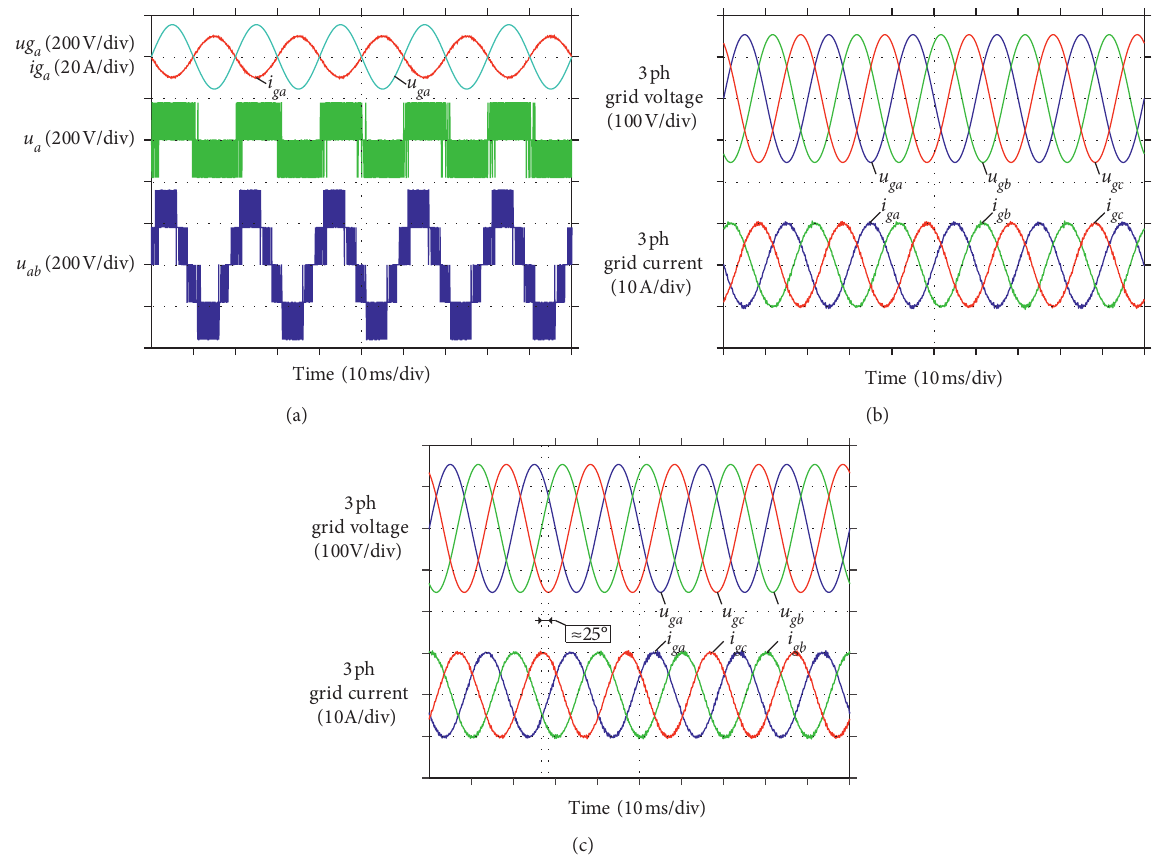
Figure 9: Simulation results of PCS in full load battery-charging condition. (a) Waveforms of u of three-phase grid voltage and current (PF � 1.0). (c) Waveforms of three-phase grid voltage and current (PF �